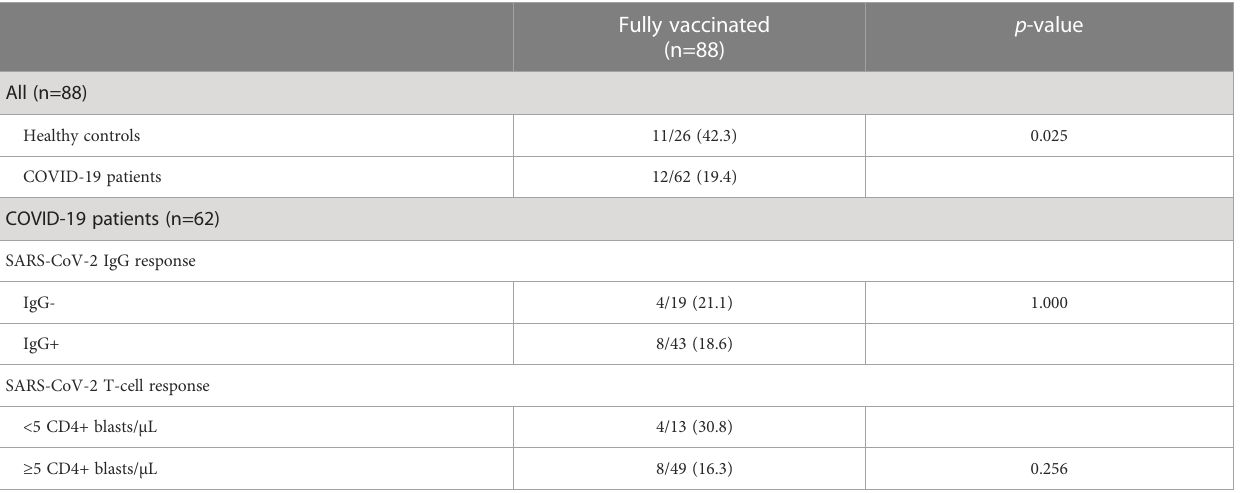
TABLE 3 Incidence of post-vaccination SARS-CoV-2 infection in fully vaccinated participants.